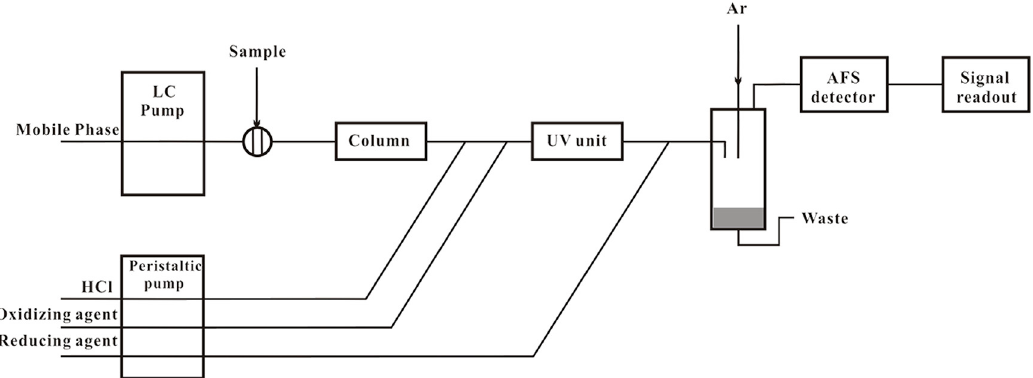
Figure 1. Scheme of the liquid chromatogram hydride generation atomic fluorescence spectrometry (LC-HG-AFS) system.